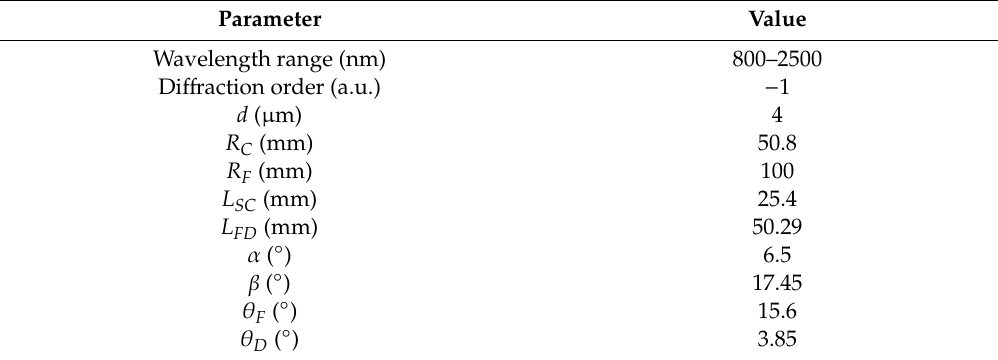
Table 2. The final design parameters of the modified optical